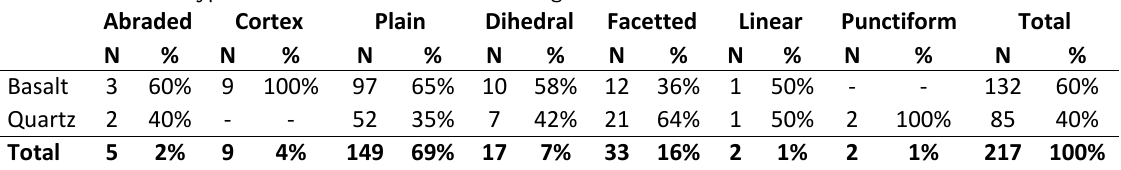
Table 9. Platform types from GOT 1-S lithic assemblages.